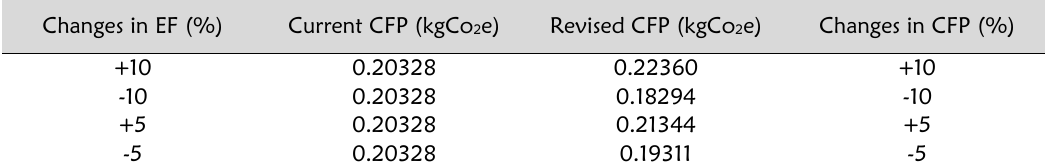
Table 4: Computed values for sensitivity analysis from the prospect of emission